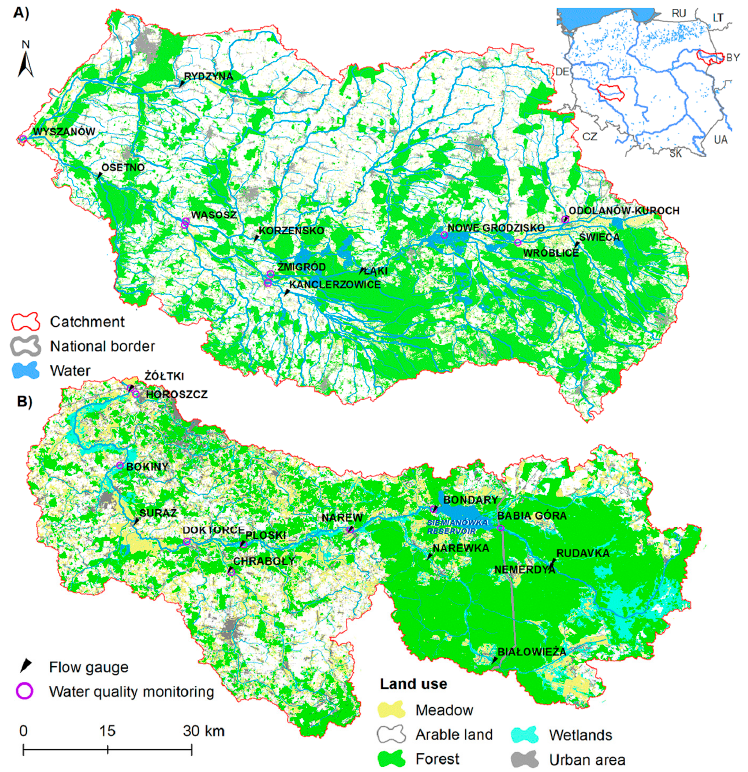
Figure 1. Location of investigated catchments: ( A ) the Barycz catchment; and ( B ) the Upper Narew catchment. Three gauges labeled with red font (Osetno and Korze ń sko for the Barycz and Ż ó ł tki for the Upper Narew) are used for showing plots of measured flow and concentrations in Figure 2.